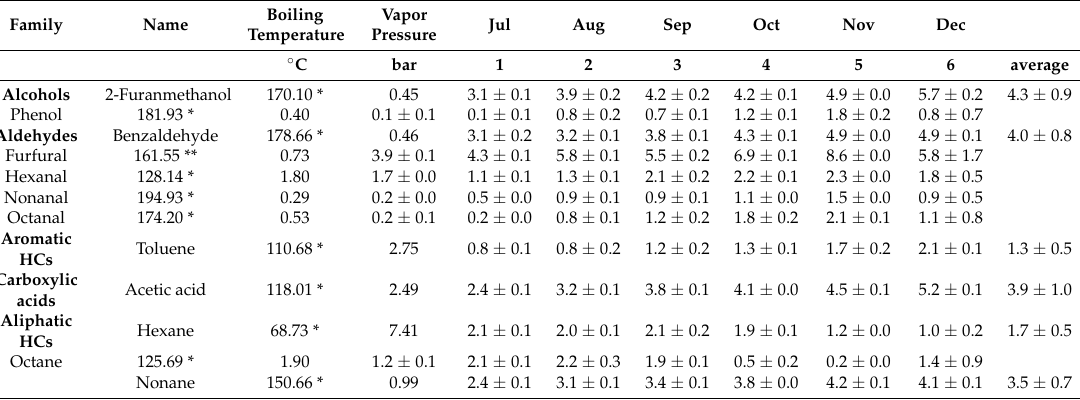
Table 5. Normal boiling temperature, vapor pressure at 150 ◦ C and the concentration of target VOCs in ppm v in exhaust gases during orujo